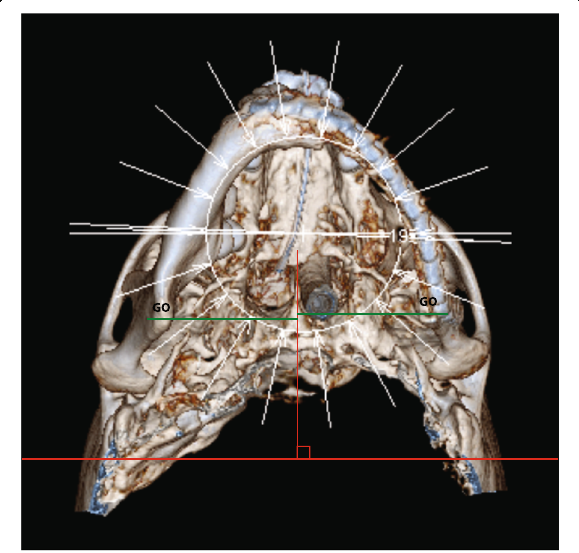
Fig. 1 Medial-lateral distances between gonion points (GO) and vomer line (VL) in the 3D-CT image (submentovertex view) were measured and compared in all